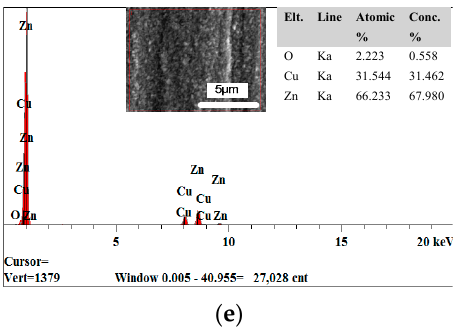
Figure 2. The energy dispersive spectrometer (EDS) results of the deposited coating with different cationic degrees. ( a ) before deposition; ( b ) deposition without CPAM; ( c ) cationic degree of 20%; ( d ) cationic degree of 40%; ( e ) cationic degree of 60%.